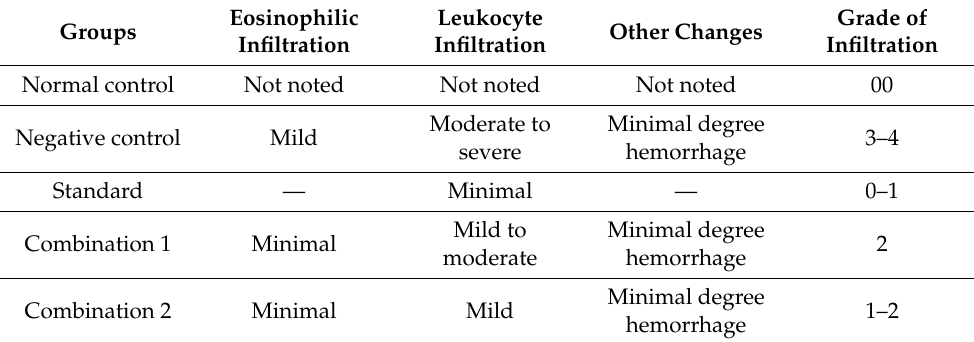
Table 4. Histopathological findings.